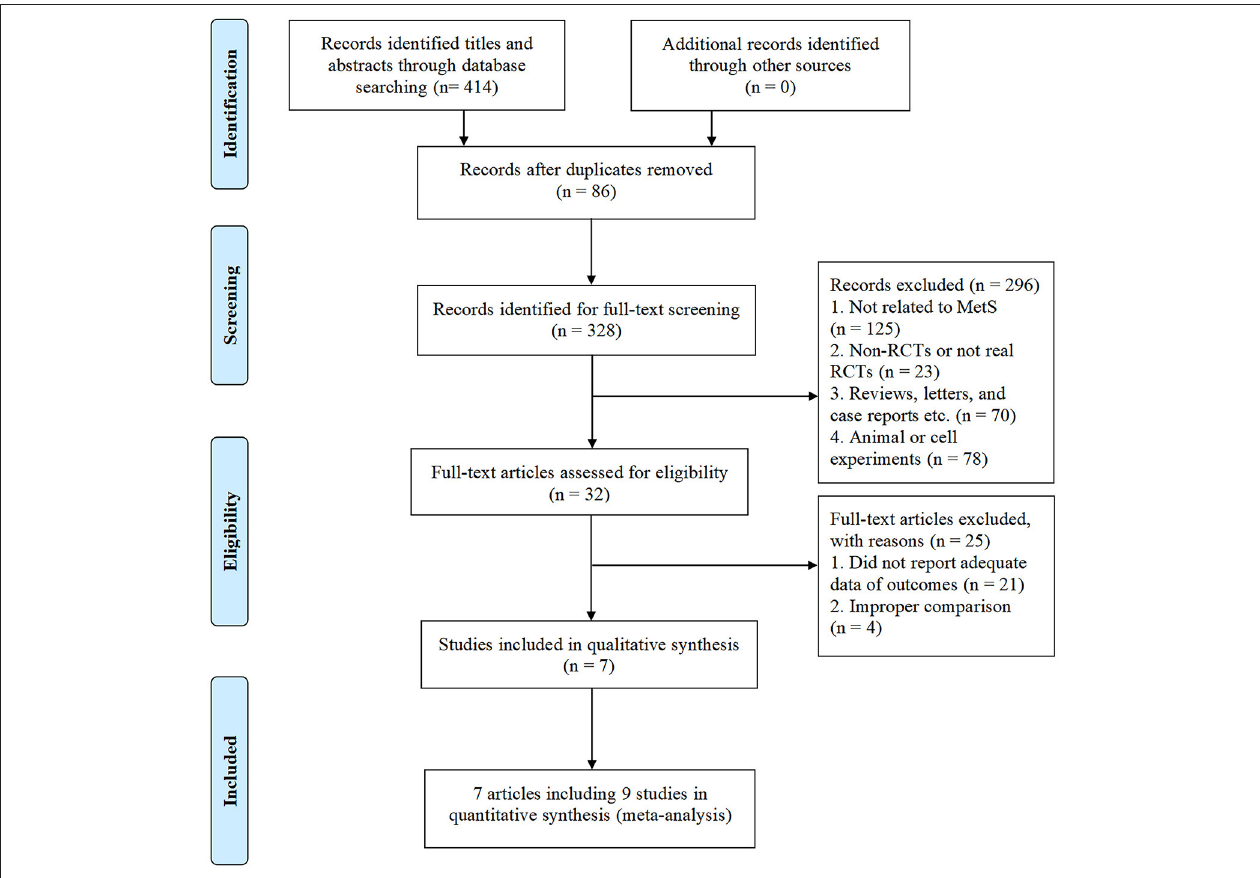
FIGURE 1 | PRISMA 2009 flow diagram for study selection